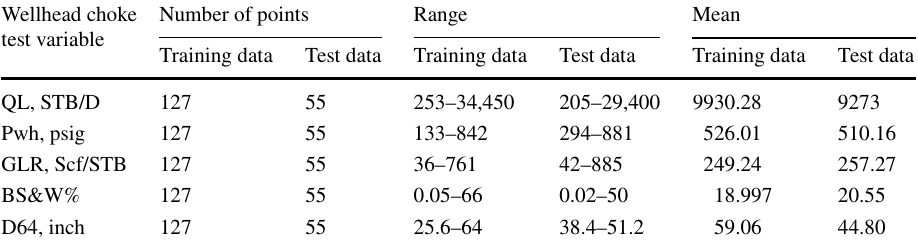
Table 2 Distribution of variable values for the Reshadat oil field